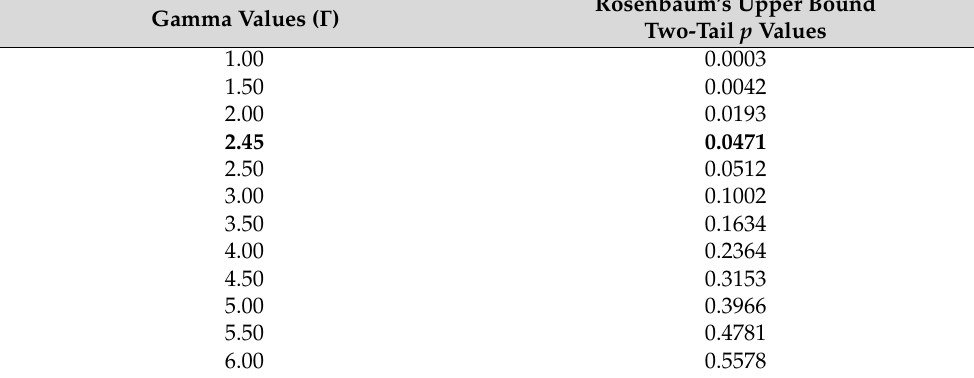
Table 4. Sensitivity analysis for the primary outcome